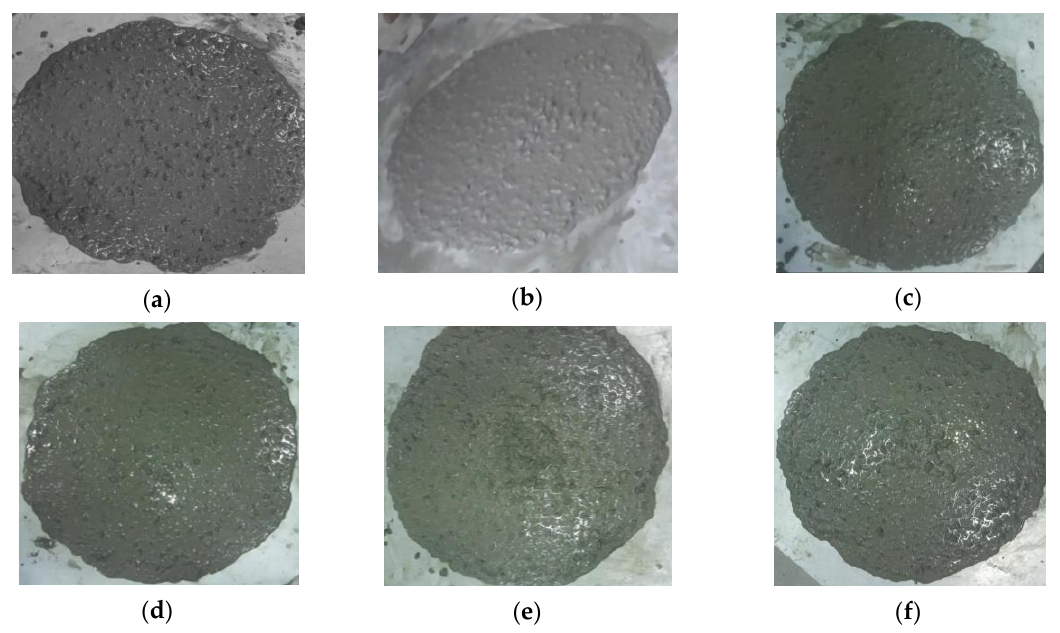
Figure 4. Effect of steel slag sand on the basic workability of SSCC after mix proportion adjustment. ( a ) slump flow (SF) and T500; ( b ) passing ability (PA) and Δh.